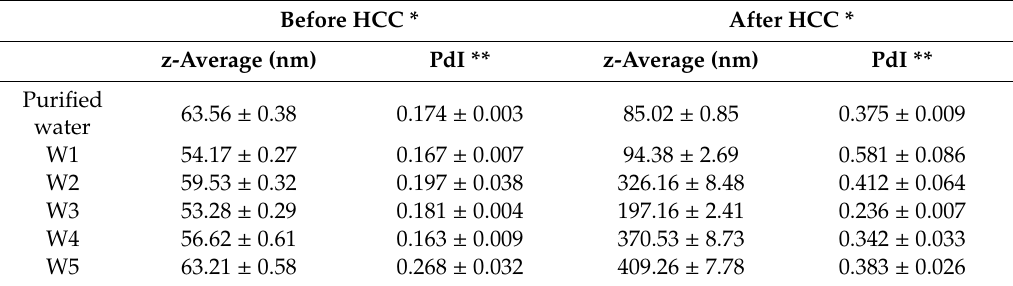
Table 4. Particle size (nm) and polydispersity index (PdI) ** before and after the HCC